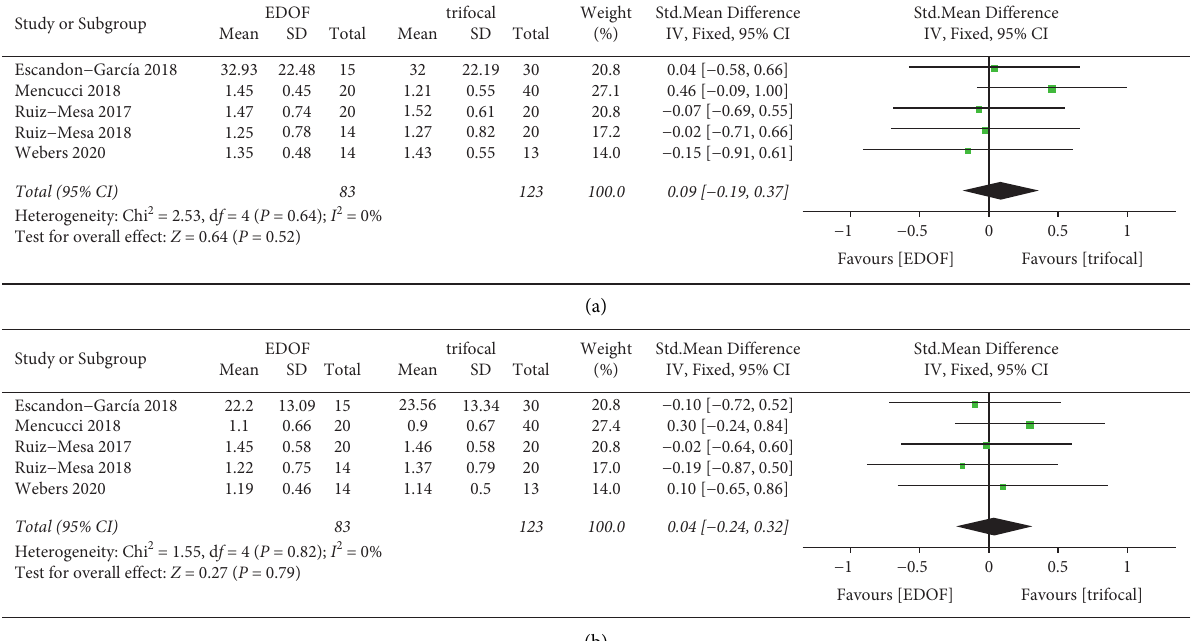
Figure 10: Forest plots of mean contrast sensitivity (CS). (a) The forest plot of CS under photopic conditions; and (b) the forest plot of CS under mesopic conditions. EDOF, extended depth-of-focus; SD, standard deviation; CI, confidence interval; IV, inverse